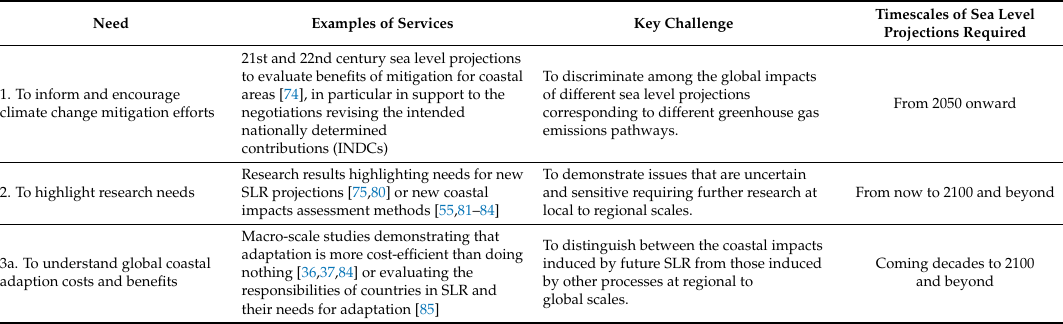
Table 2. Coastal climate services based on sea level scenarios or